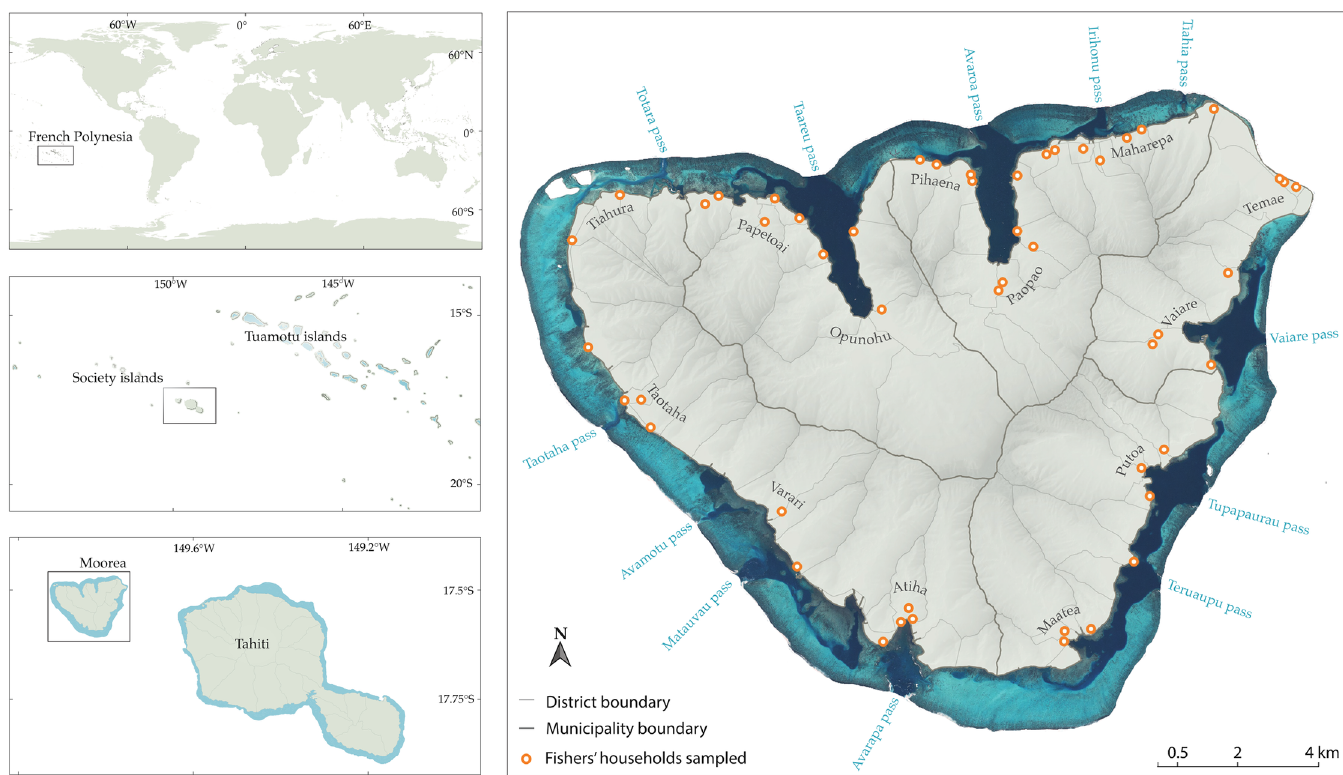
Fig 2. Map of Moorea Island, French Polynesia. Orange circles represent the locationof householdssurveyedto quantify criteria and sub-criteriaweights. Thick lines denote municipality boundaries and thin lines district boundaries.Key place names are indicatedeither in blue(reef passages) or in black